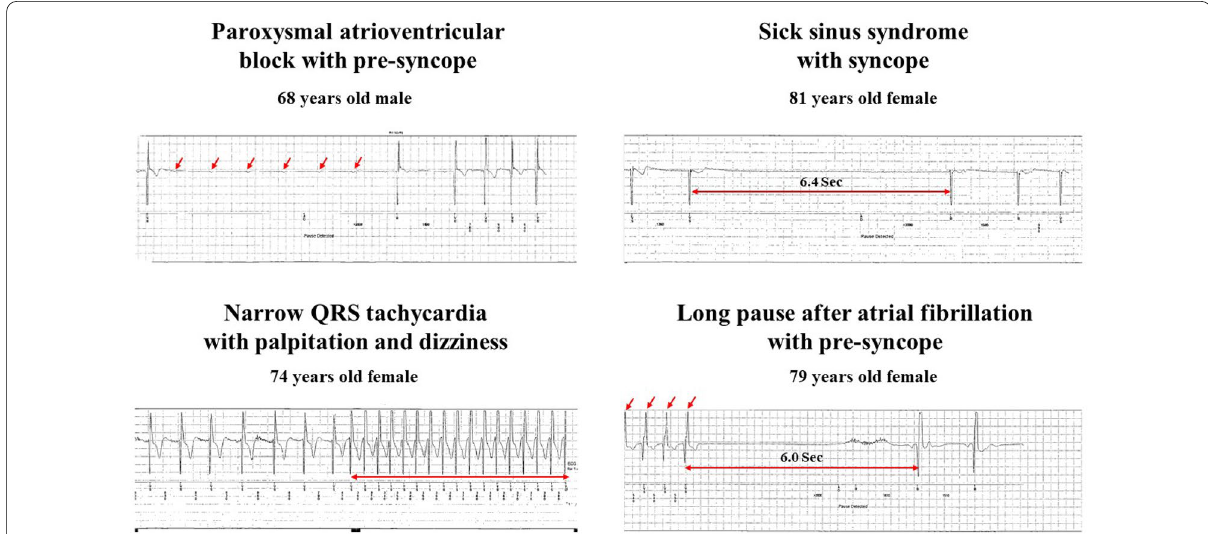
Fig. 2 Representative examples of arrhythmias that were detected in the tracings downloaded from the ILR at the time of symptoms